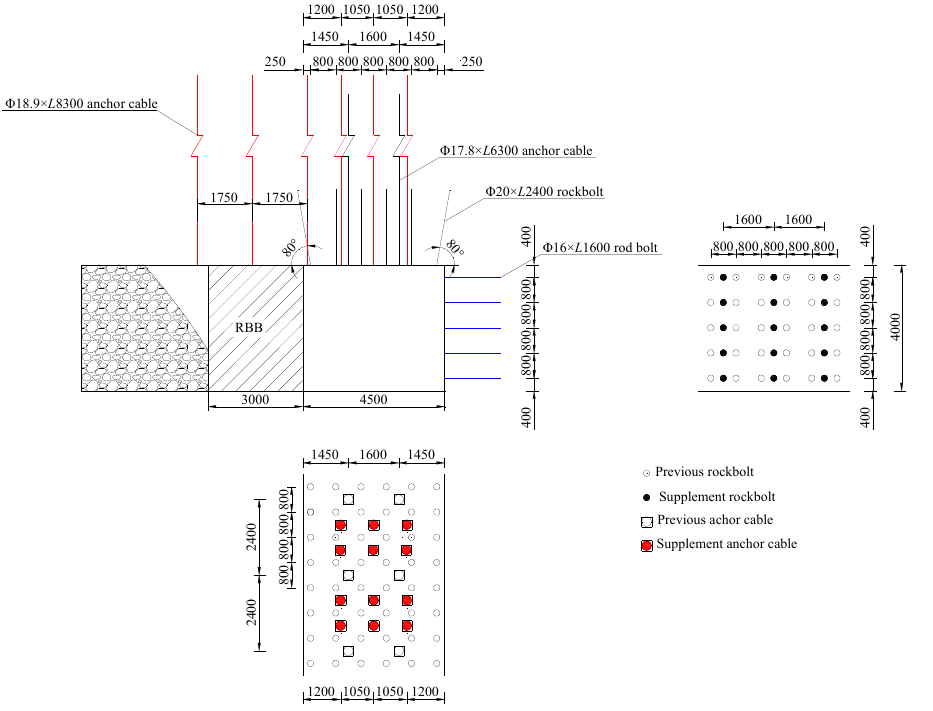
Figure 14. The 4211 air-return entry support layout for GER (units: mm).